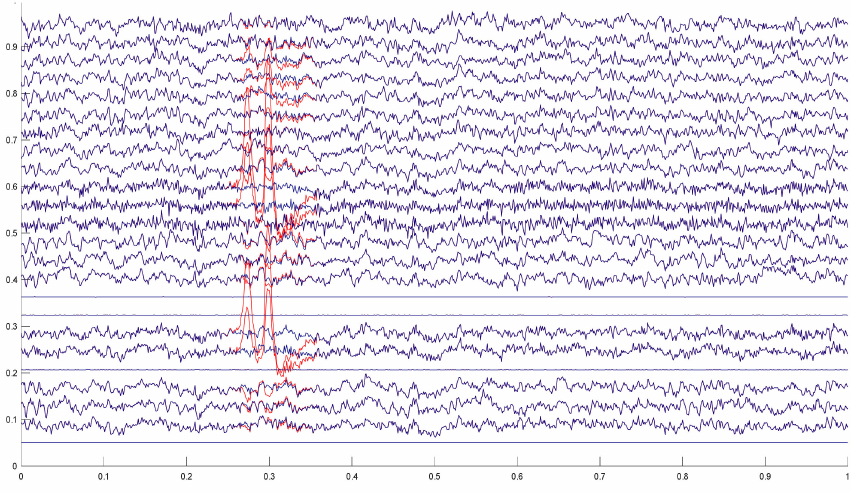
Figure 4. Rejection of bad data (red lines) using EEGLAB.